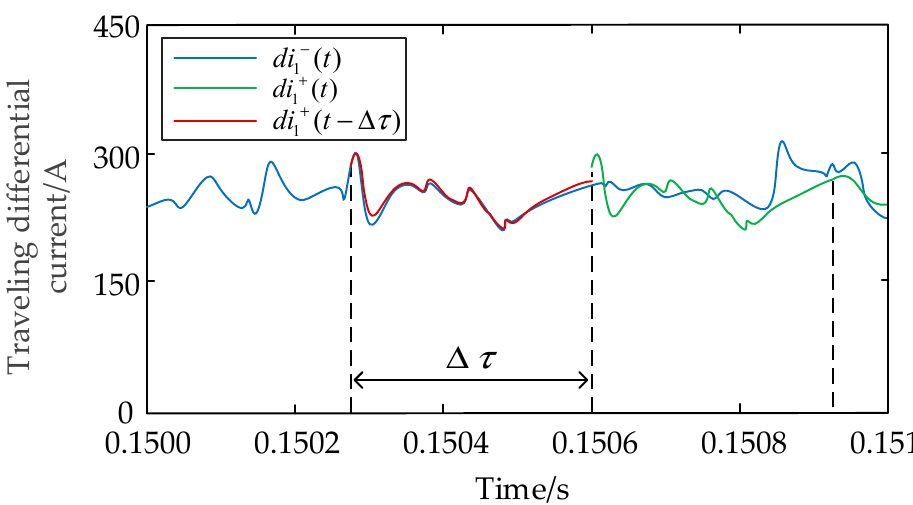
Figure 4. Traveling differential for pole-to-pole short-circuit.